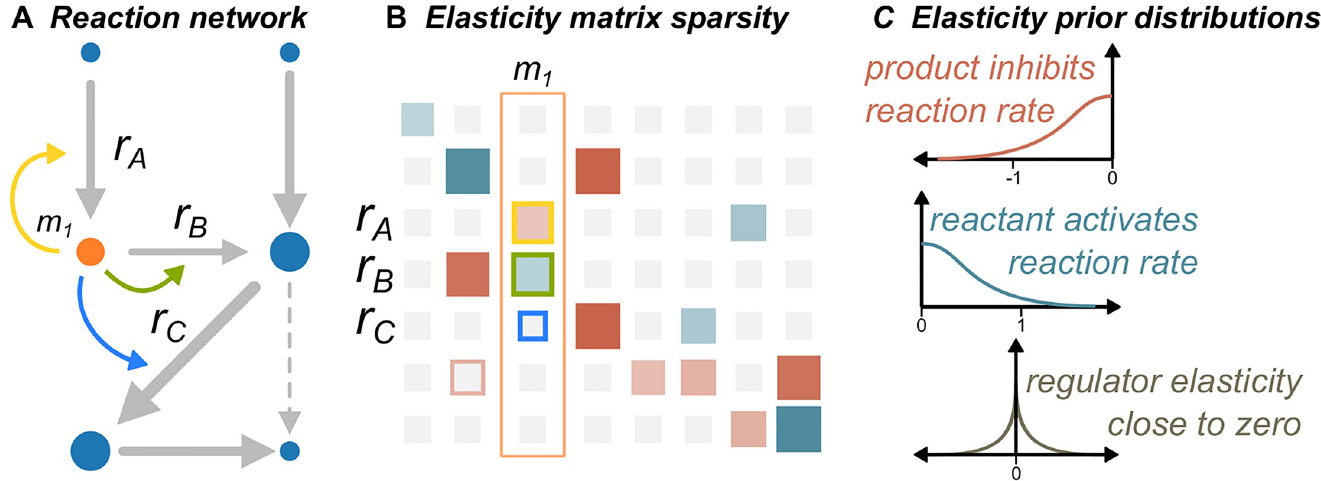
Fig 1. Overview of the modeling framework. (A) The stoichiometry of the reaction network is used to determine prior distributions for the elasticity parameters. (B) The elasticity parameters represented in matrix form, where the column outlined in orange corresponds to m 1 in (A). (C) For a metabolite m 1 , the prior distribution has predominately negative support for reactions in which the metabolite is a product ( r A ), positive support for reactions in which the metabolite is a reactant ( r B ), and a zero-centered, sparsity inducing prior for reactions in which the metabolite does not participate ( r